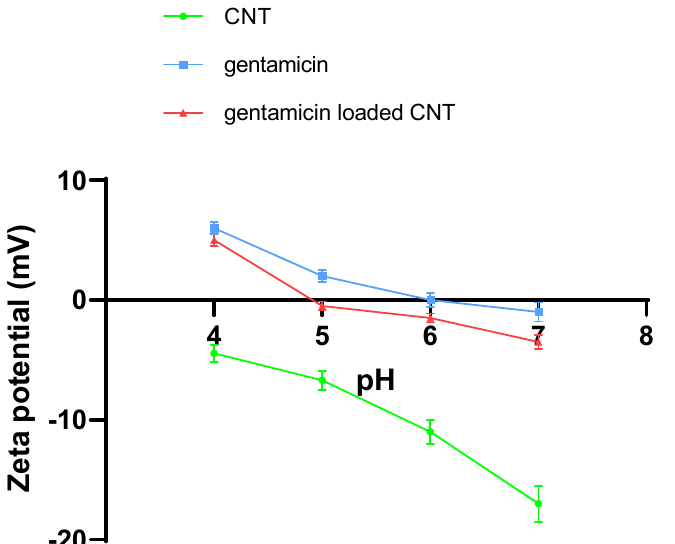
Figure 3. Zeta potentials of CNT, gentamicin, and gentamicin-loaded CNT at different pH values ranging from 4 to 7 (mean ± SD, n = 3).